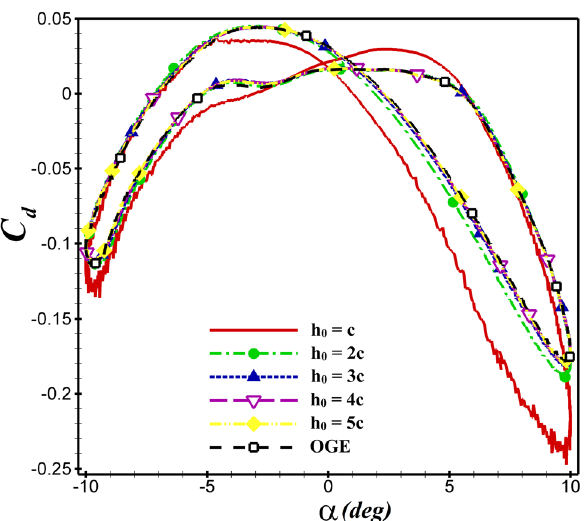
Figure 9. The C d of dragonfly airfoil in different h 0 over one oscillation period (OGE means out of ground